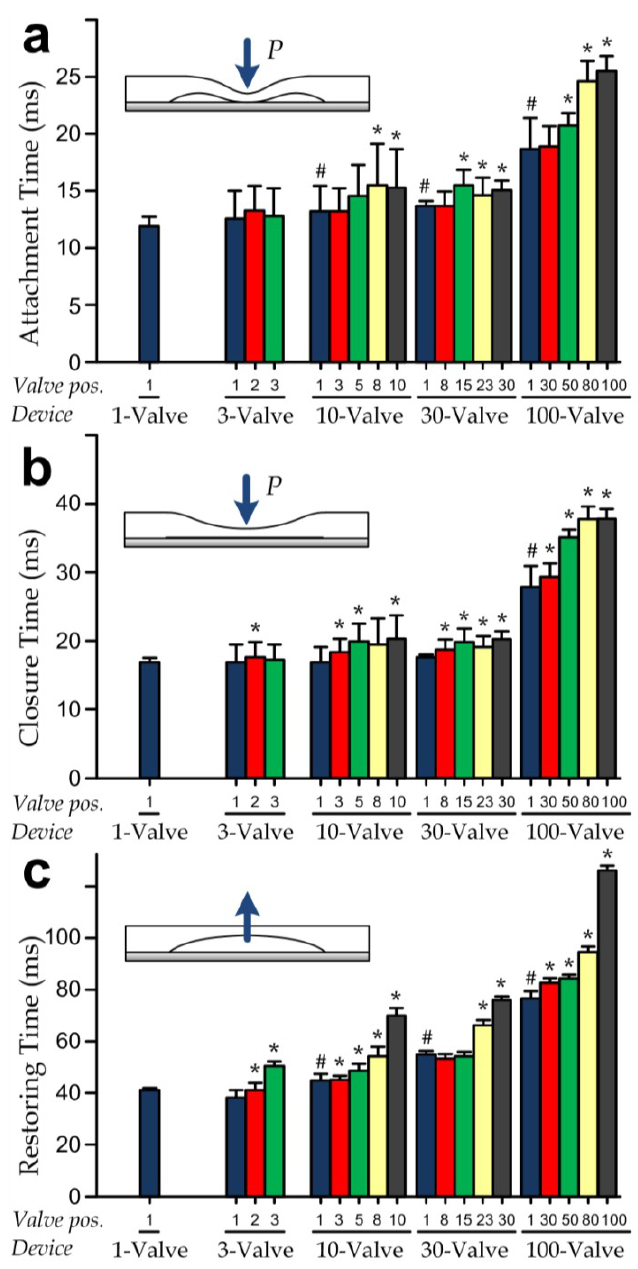
Figure 4. Bar charts showing response times of microfluidic devices with different numbers of valves connected in serial. ( a ) Attachment time; ( b ) closure time; and ( c ) restoring time of selected valve positions are listed for devices with 1, 3, 10, 30 and 100 microvalves. Error bars represent the standard deviations. Hashes indicate significant time increments ( p < 0.05) of the valves closest to the gas inlets (“position 1”) in different multi-valve devices relative to the single-valve ones. Each asterisk indicates a significant time increment ( p < 0.05) of a microvalve comparing to the valve at “position 1” of the same device